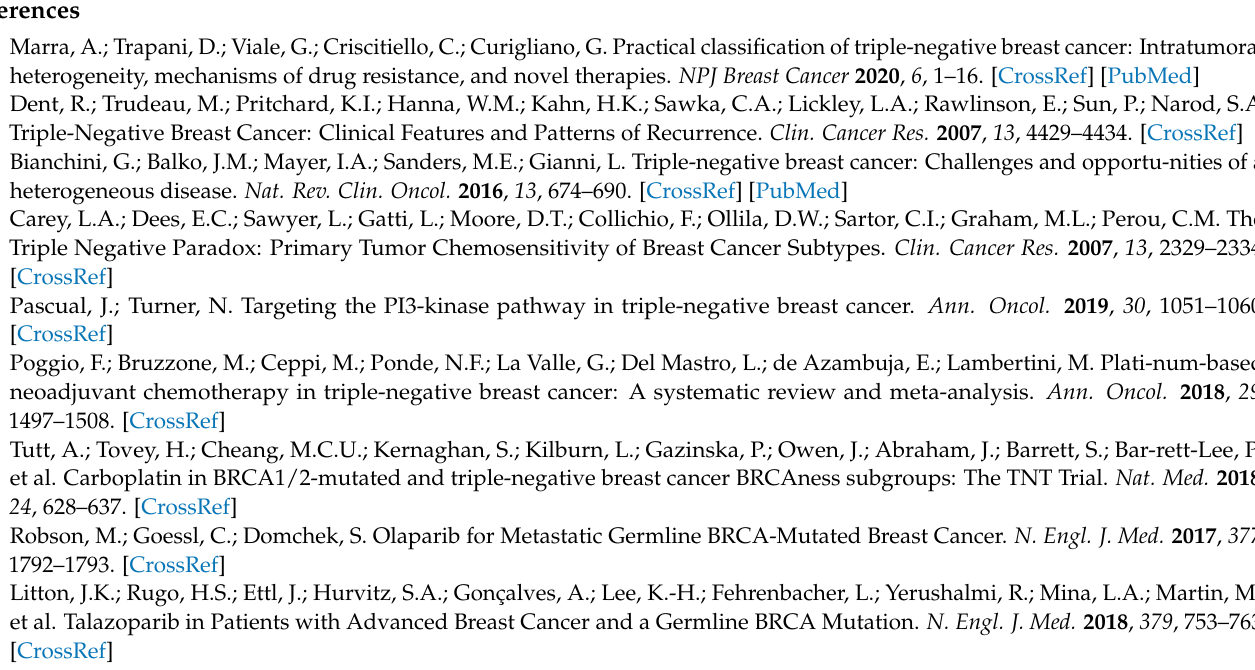
tumorspheres, Figure S1: Correlation between gene expression and patients’ prognosis, Figure S2: Characterization of MDA-MB-231 cells and derived tumorspheres, Figure S3: TENM4 expression in breast cancer and in plasma from patients, Figure S4:TENM4 role in HCC1806 CSC self renewal and migratory ability, Figure S5: Effect of TENM4 silencing on CSC markers expression in murine and human TNBC stem cells; original blot